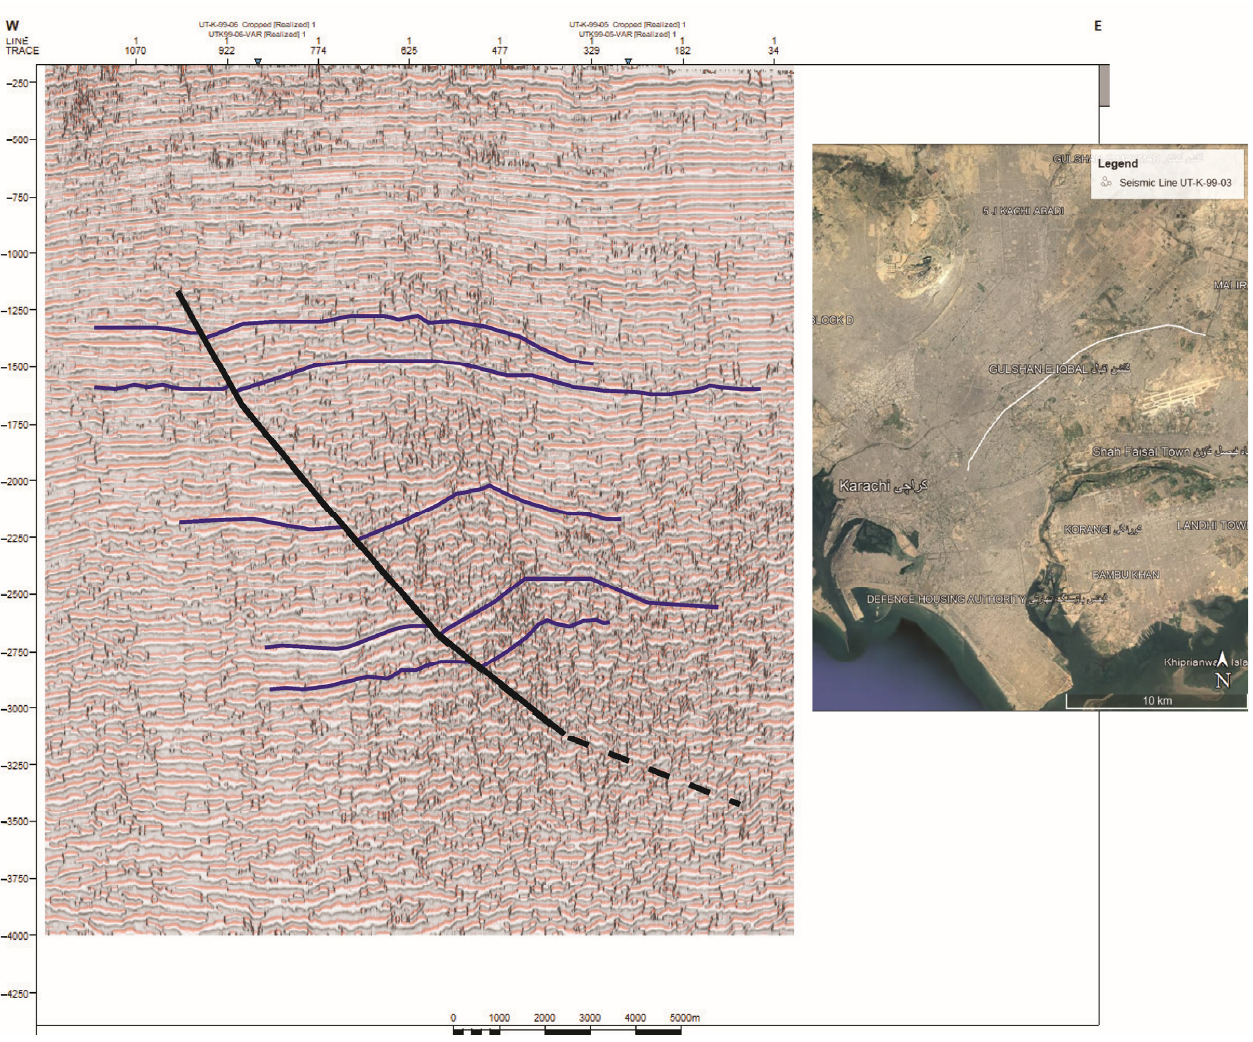
Figure 8. 2D seismic data ( left ) visualized using quadrature amplitude overlain with variance showing fault (black) and clear reflectors (blue). Google Earth image showing map view of seismic line ( right ). Table 1. Results of GBIS fault modeling.